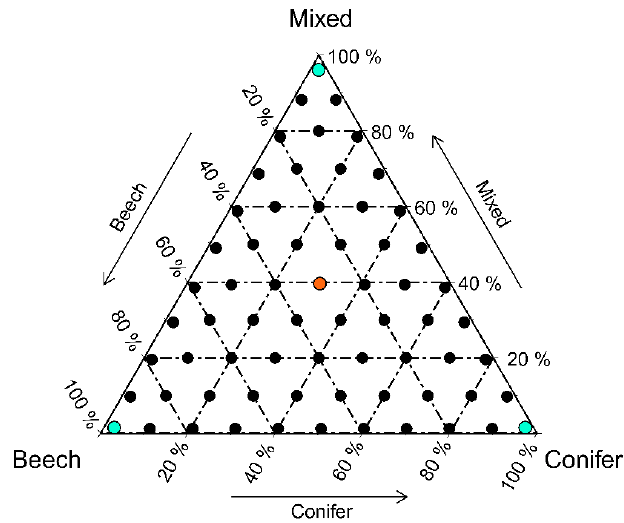
Figure 1. Stand type compositions (66 points) representing all combinations of pure beech, pure conifer and mixed stands in steps of 10% and arranged within a schematic triangle. The corners represent hypothetical forest landscapes of 100% pure beech, pure conifer and mixed stands, respectively (cyan points). Towards the center of the triangle, the three stand types are mixed with the center point (orange point) representing a composition with 40% mixed, 30% pure beech and 30% pure conifer stands.